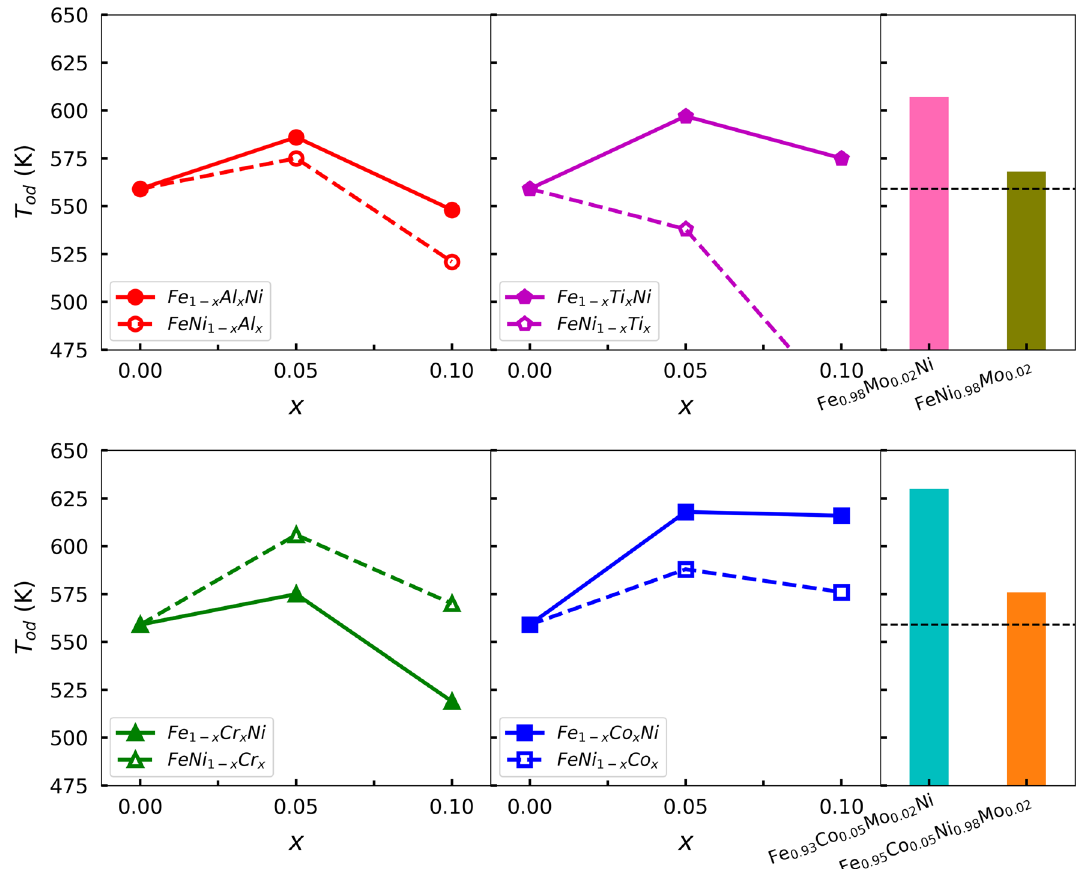
Figure 3. The order–disorder transition temperatures of Fe 1 − x M x Ni and FeNi 1 − x M x ( M = Al , Ti, Cr, Co), as well as Fe 0.98 Mo 0.02 Ni , FeNi 0.98 Mo 0.02 , Fe 0.93 Co 0.05 Mo 0.02 Ni and Fe 0.95 Co 0.05 Ni 0.98 Mo 0.02 as a function of the M concentrations. The dashed lines represent the T od (559 K) of L1 0 FeNi in the last